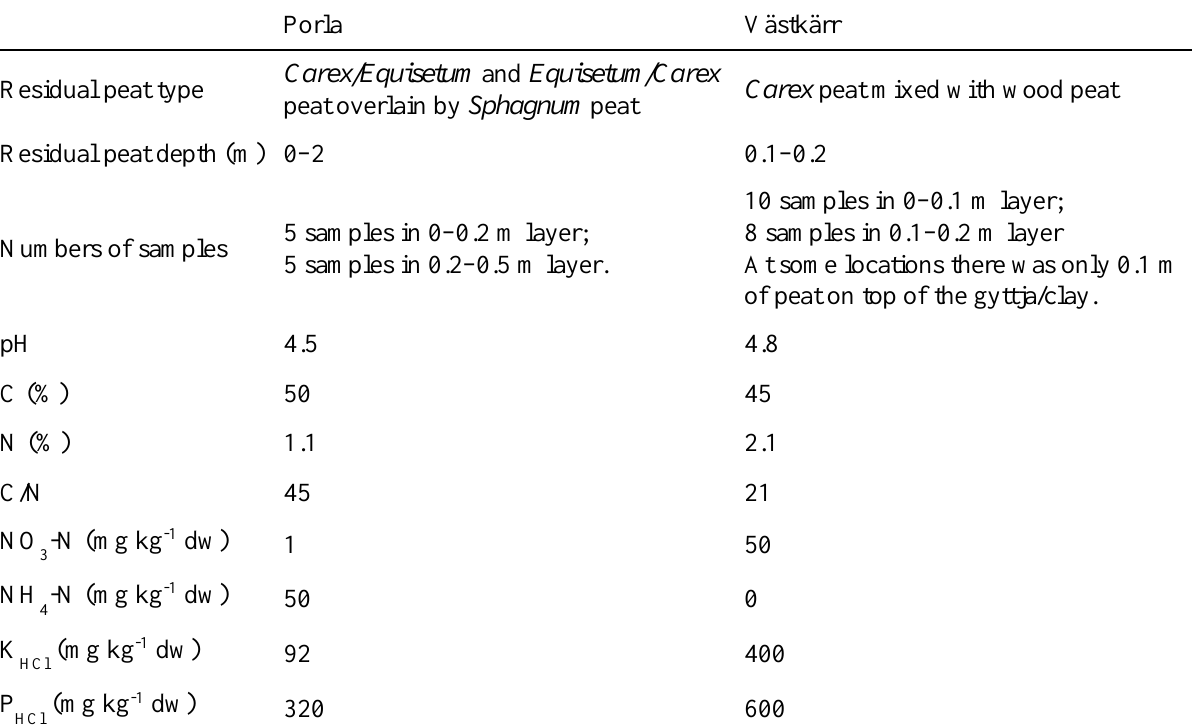
Table 2. Characteristics of residual peat and chemical characteristics of upper-layer peat at Västkärr and Porla before rewetting. Samples were randomly located and distributed over almost the whole of each